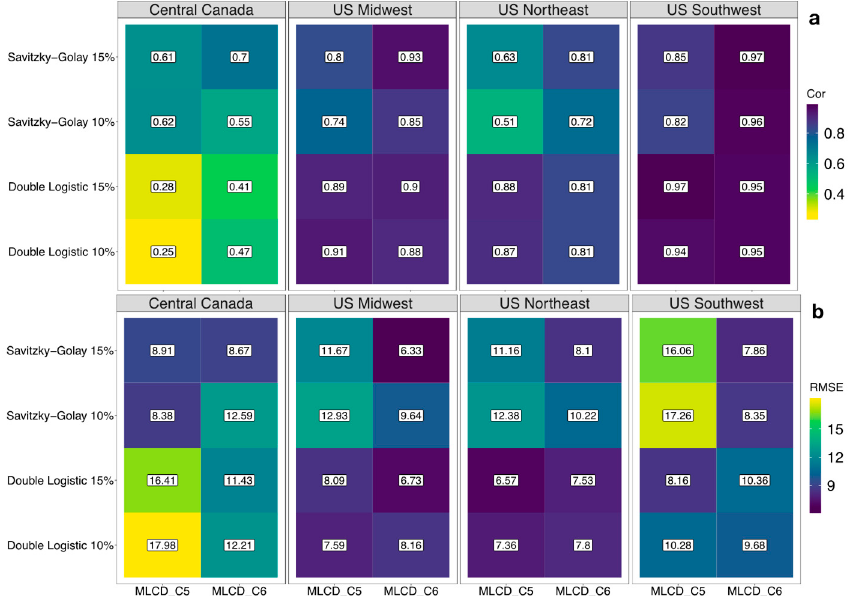
Figure 3. Summary statistics comparing phenological transition dates extracted from TIMESAT with those obtained from the MODIS C5 and C6 MLCD products across 12 years from 2003 to 2014 for four MODIS tiles in Central Canada, US Midwest, US Northeast and US Southwest. Panel ( a ) shows the correlation, and panel ( b ) shows the RMSE in days for start of season (SOS). We used two thresholds corresponding to 10% and 15% of the seasonal amplitude of EVI. All correlation values are statistically significant at p<0.05.